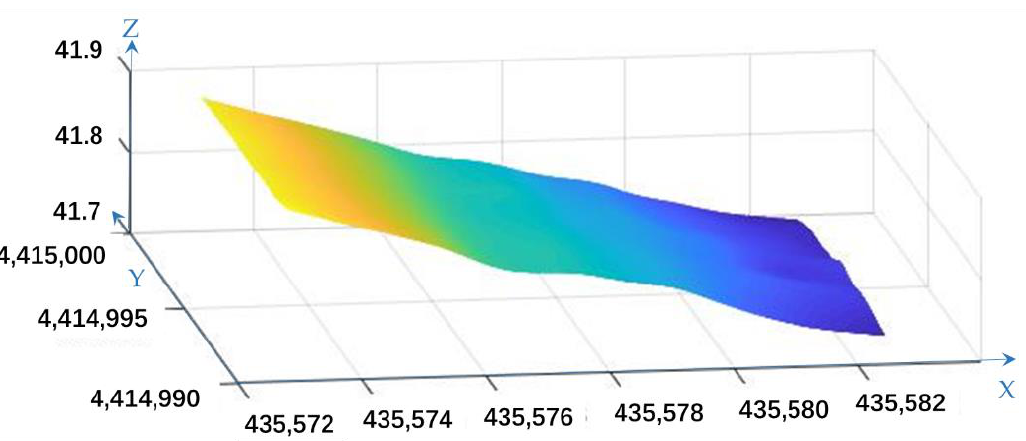
Figure 14. A portion of the Gaussian smoothing results (m).